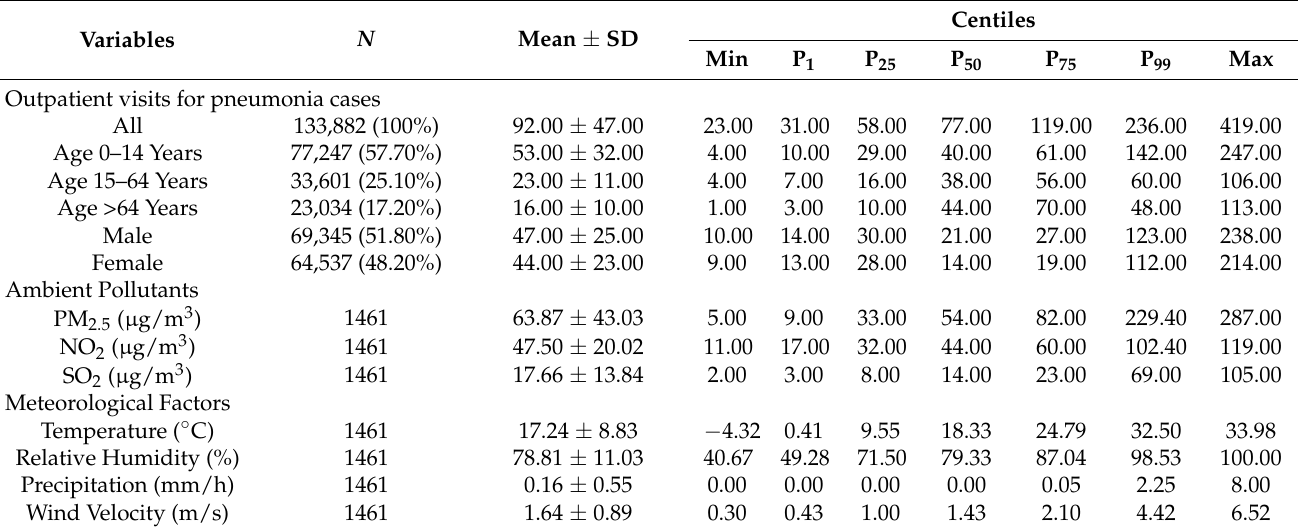
Table 1. Description of outpatient visits for pneumonia cases, air pollutants, and meteorological factors in Wuhan from 1 January 2014 to 31 December 2017.